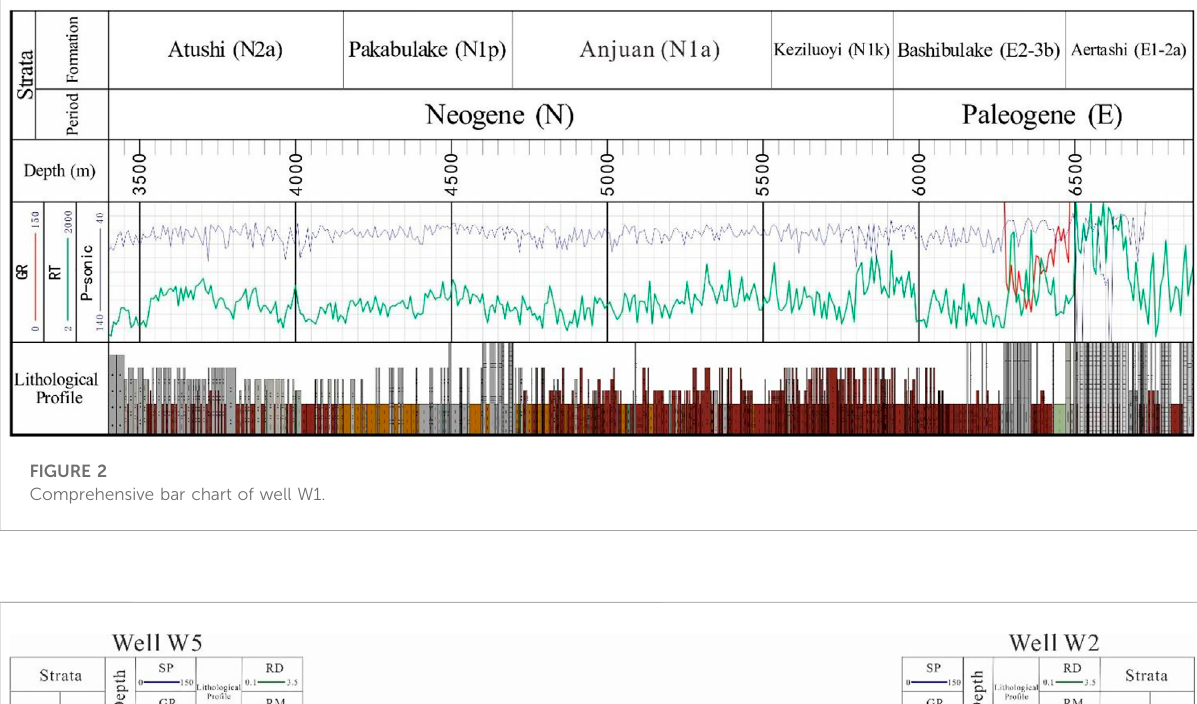
FIGURE 2 Comprehensive bar chart of well W1.